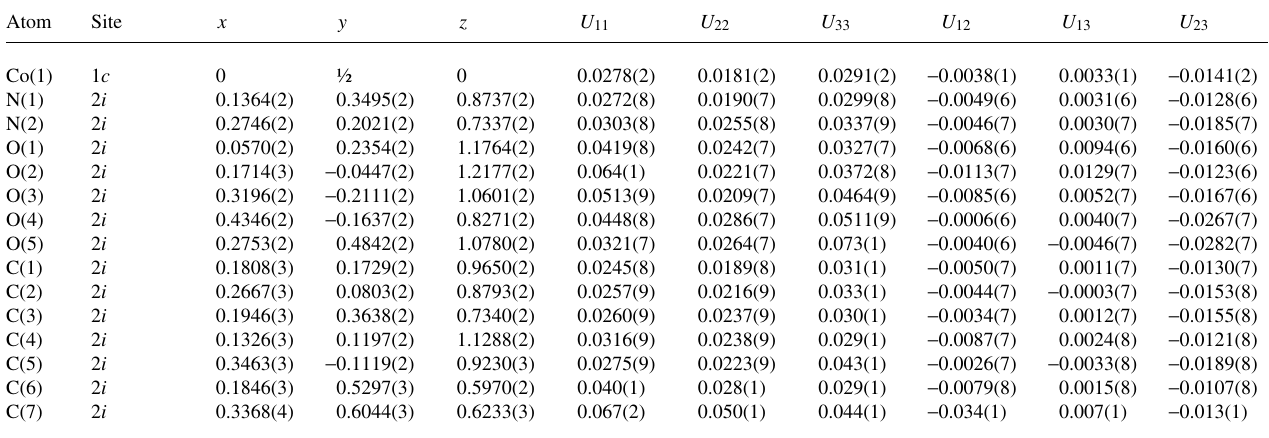
Table 3. Atomic coordinates and displacement parameters (in Å 2 ) .